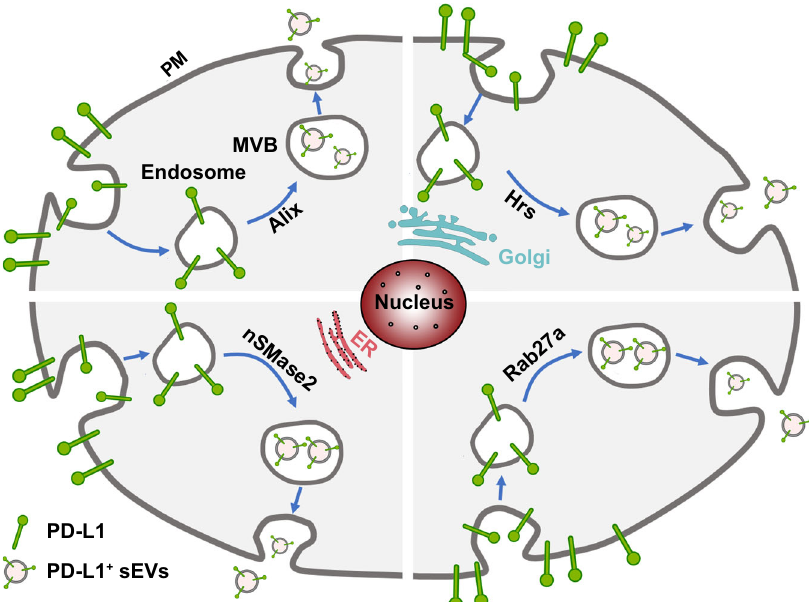
Fig. 1 Biogenesis, traf fi cking, and secretion mechanisms of sEV PD-L1. PD-L1 was shifted from plasma membrane (PM). The early endosomes were formed by the internalization of the plasma membrane. Then, early endosomes undergo the process of mature. The early endosomal membrane buds inward to form small intraluminal vesicles (ILV), which also known as late endosome or multi-vesicular body (MVB). Finally, MVBs fuse with the plasma membrane to release ILVs containing PD-L1, which is known as sEV